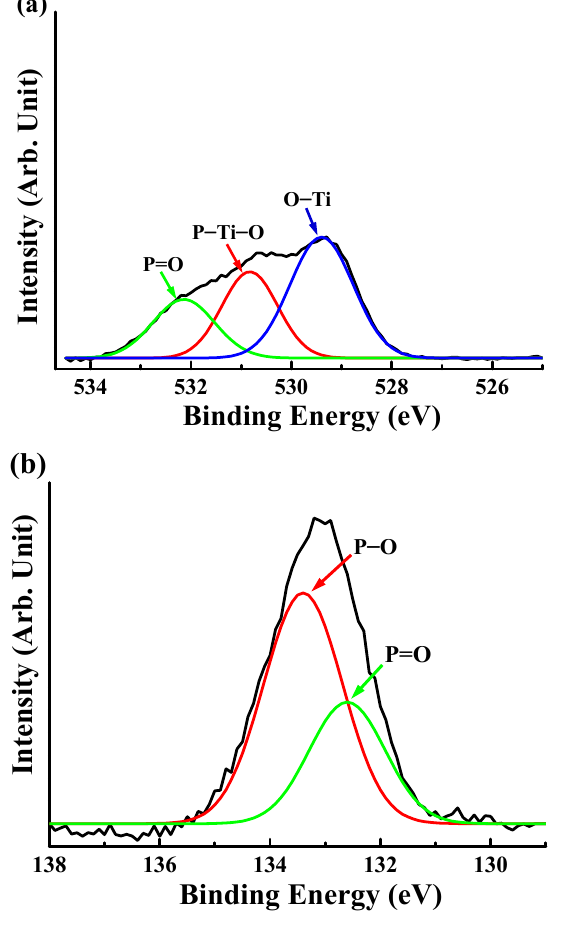
Figure 4. The high-resolution XPS survey spectra of the SAMs-coated samples.